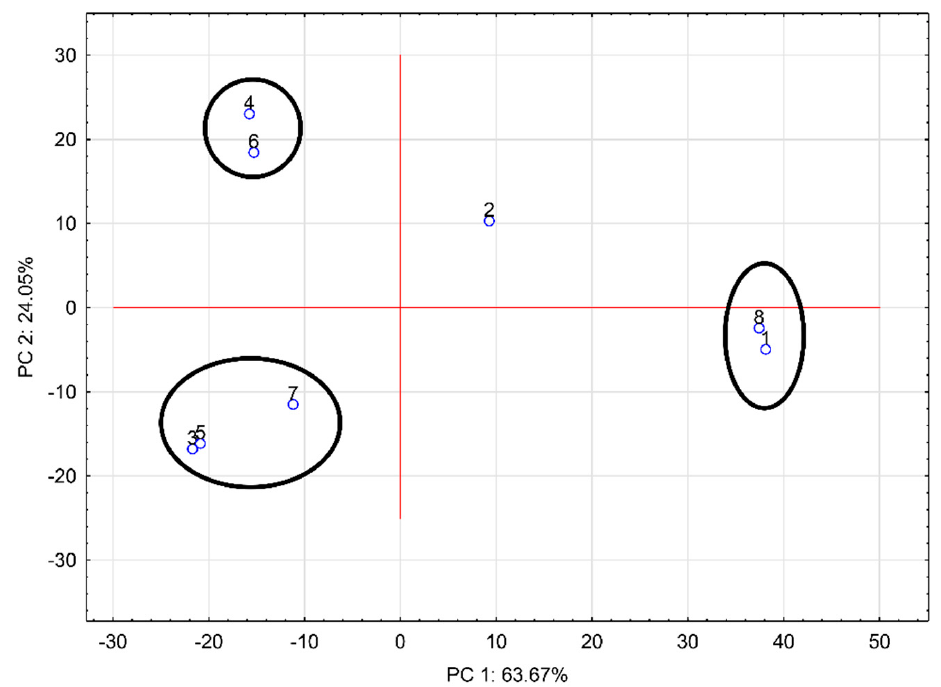
Figure 5. Principal component analysis of the mass spectra of all samples; negative mode, ionization temperature 400 °C (1: 2% CMC; 2: 2% CMC-30% S; 3: 2% CMC-30% T; 4: 2% CMC-40% S; 5: 2% CMC-40% T; 6: 2% CMC-50% S; 7: 2% CMC-50% T; 8: chokeberry juice; CMC: carboxymethylcellulose; S: sucrose; T: trehalose).